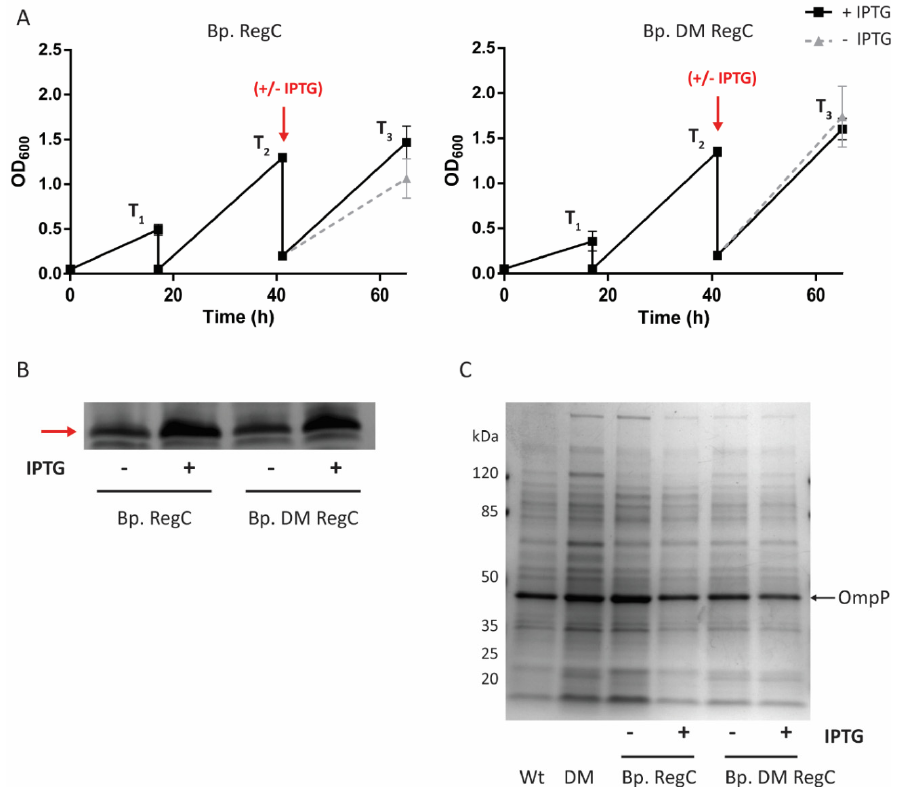
Figure 2. Growth of B. pertussis strains with regulatable lpxC during LPS-depletion conditions and characterization of the cell content. ( A ) Growth curves of Bp. RegC (left panel) and Bp. DM RegC (right panel) were measured at OD 600 following the LPS-depletion growth protocol discussed in the text. At T 2 , bacterial cultures were washed and grown further either without IPTG (grey dashed line) or with 1 mM IPTG (black solid line). Graphs show mean values with standard deviations of three independent experiments. No significant differences were found with a paired t -test; ( B ) Analysis of the LPS content of cells by SDS-PAGE. Samples taken at T 3 in panel A were adjusted based on OD, analyzed by SDS-PAGE, and LPS was visualized by silver staining. Only the relevant part of the gel is shown. The band corresponding to LPS is indicated with an arrow; ( C ) The protein content of OM preparations from Bp. RegC and its wild-type parental strain (Wt) and from Bp. DM RegC and its parental strain (DM) was analyzed by SDS-PAGE. The major OM protein, porin OmpP, is indicated with an arrow at the right. Molecular-weight markers are indicated at the left.